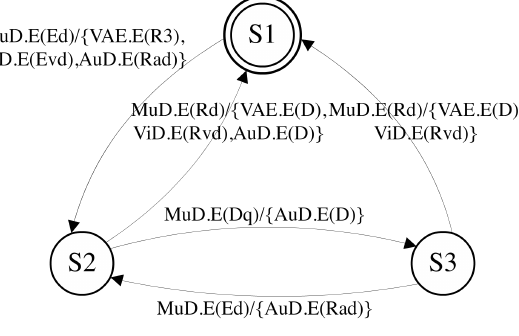
Figure 6. MMA composition for